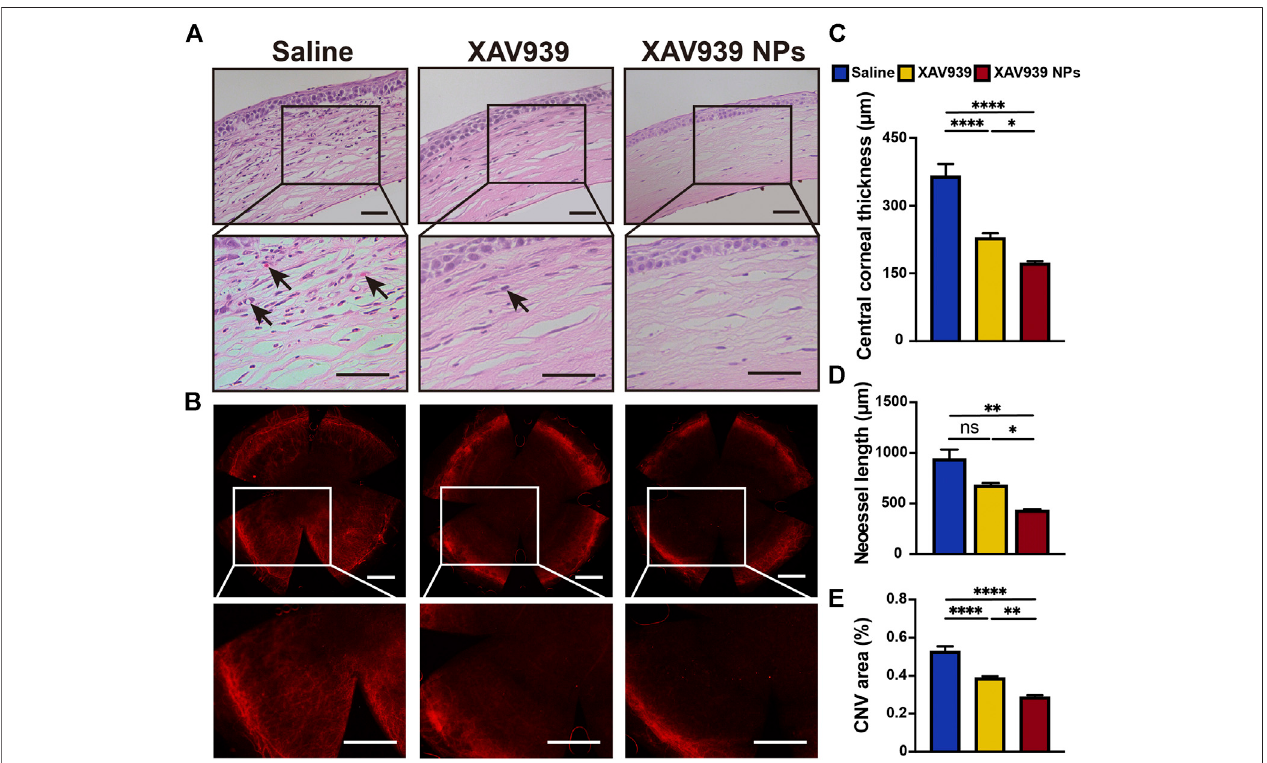
FIGURE 5 | Immunohistochemistry and immuno fl uorescence assessments of the corneal sections. (A) H&E staining of the corneal sections following 14 days of the indicated treatment. The black arrows mark the CNV sites. Scale bar: 50 μ m. (B) CD31 corneal fl at mount staining of the corneal sections following 14 days of the indicated treatment. Scale bar: 500 μ m. Quanti fi cation of the central corneal thickness (C) , neovessel length (D) , and CNV area (%) (E) . Results are presented as the mean ± SEM. n (cid:2) 3. (One-way ANOVA, * p < 0.05, ** p < 0.01, **** p < 0.0001, ns, not signi fi cant).